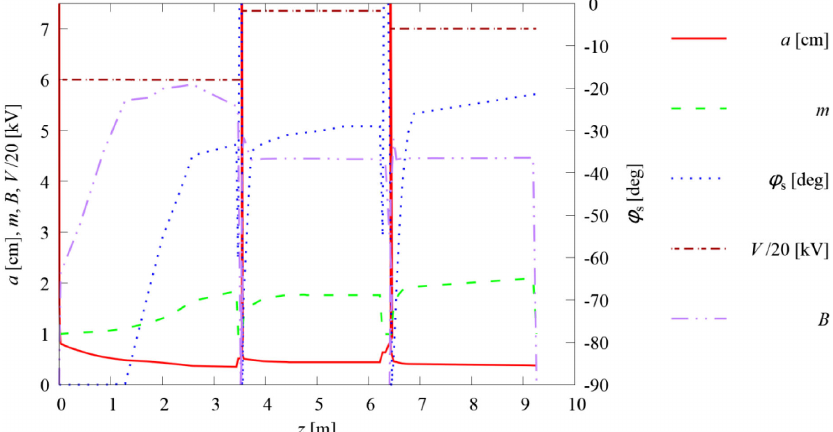
FIG. 15. Main design parameters of the “ 3-RFQ with drift ” solution.